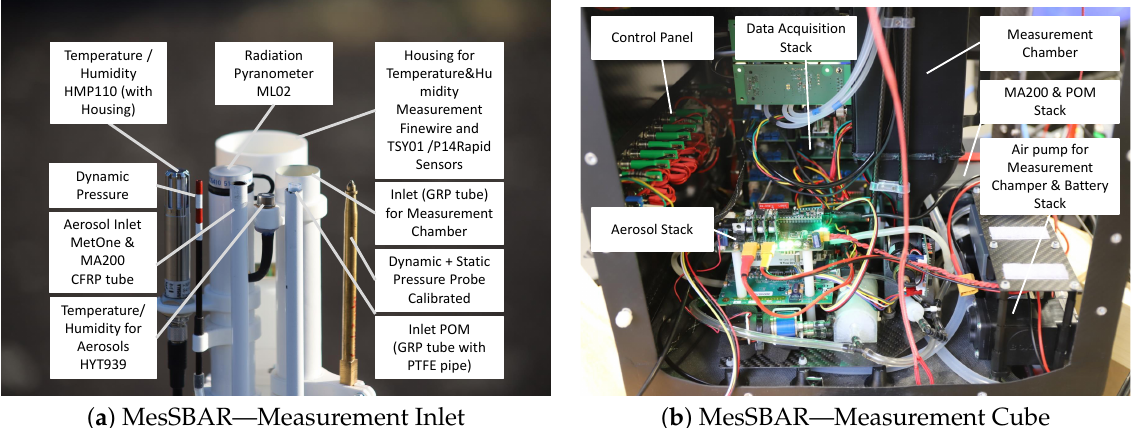
Figure 3. MesSBAR quadrocopter—detailed view of the Measurement Cube and the